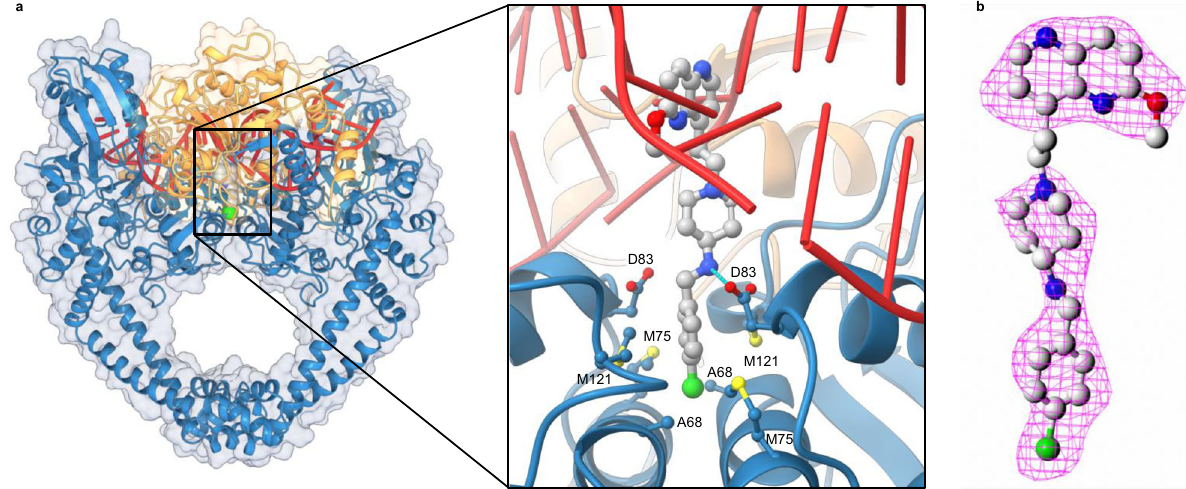
Fig. 4 The S. aureus DNA gyrase in complex with 4 and DNA. a The 2.3-Å resolution crystal structure of compound 4 bound to a DNA – gyrase complex (PDB ID: 6Z1A). GyrA and GyrB are represented as cartoons in blue and yellow, respectively. 4 is represented as balls and sticks colour coded by elements and DNA as cartoon in red. The single hydrogen bond to the ligand is shown as blue dots. b Omit m F obs − D F calc difference electron density for the bound ligand (magenta mesh) calculated at 2.3-Å resolution and contoured at 1.6 σ . This shows clearly the asymmetry of the compound, including the intercalating